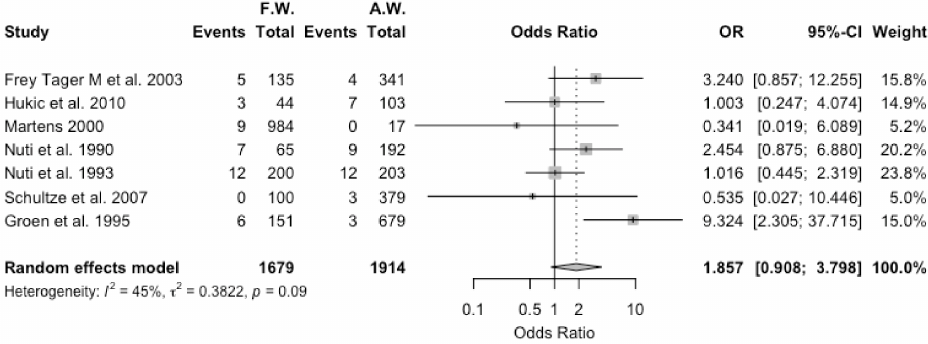
Figure 6. Forest plot comparing the positive status for hantavirus serology (i.e., “Event”) in forestry workers (FW) and agricultural workers (AW) in studies that reported on both occupational groups. In summary, working as FW was associated with seropositive status with an odds ratio (OR) equal to 1.857, 95% confidence interval (95% CI)